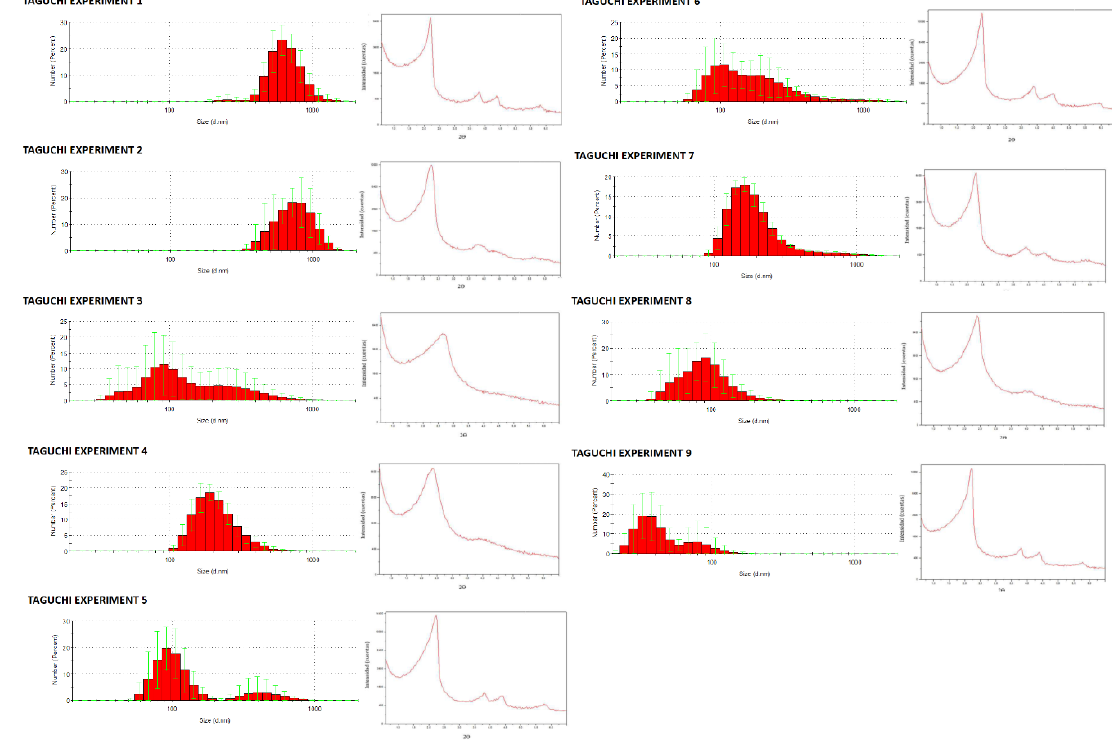
Figure 2. Dynamic Light Scattering (DLS) size distributions and Small Angle X-rays Scattering (SAXS) data for all the different Taguchi optimization experiments. Synthetic details are compiled in Table 1. DLS measurements were recorded in EtOH and are the average of 5 measurements. Graphic scales for SAXS range from 0 to 6.5 (2 θ ) and from 0 to 10 5 counts following a potential curve (400x 2 ). For DLS measurements y axis show percentages while the abscissa scale is logarithmic from 20 to 2000 nm.